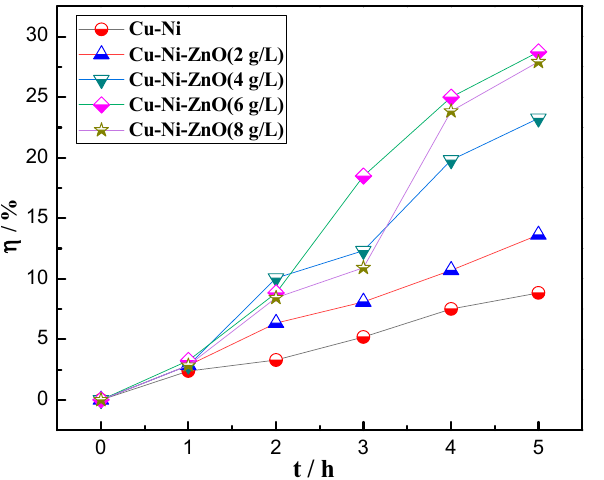
Figure 10. Illumination time and decolorization rate of Cu-Ni-ZnO nanocomposite coatings with different (Cu, Ni)-ZnO additions.